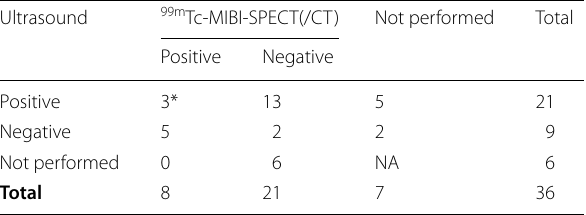
Table 2 Preoperative localization results of ultrasonography and 99m Tc-MIBI-SPECT(/CT) of 36